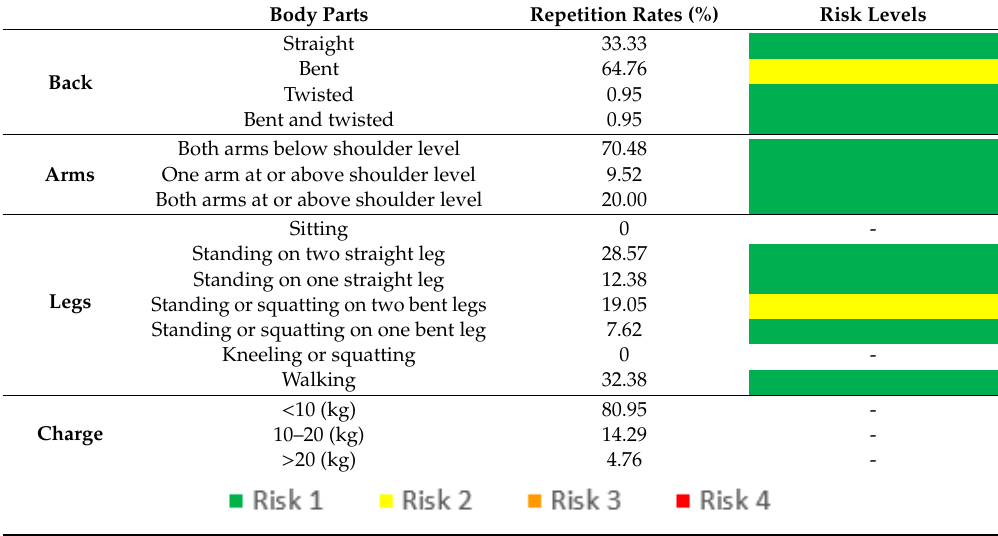
Table 6. Risk level and repetition rate of the position of each body part and of the weight of the handled load for the entire courgette cultivation.